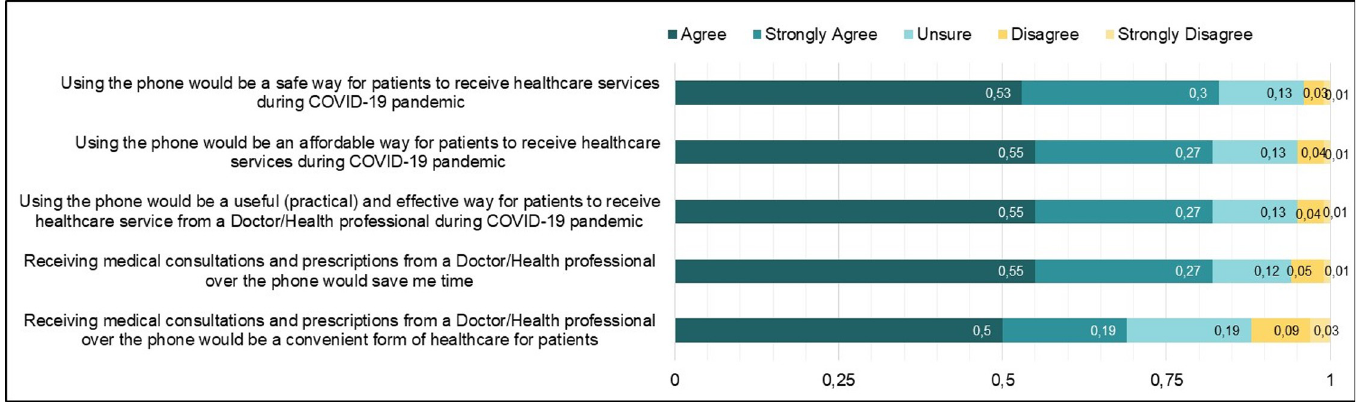
Fig 4. Healthcare consumers perception on the benefits of telemedicine use.